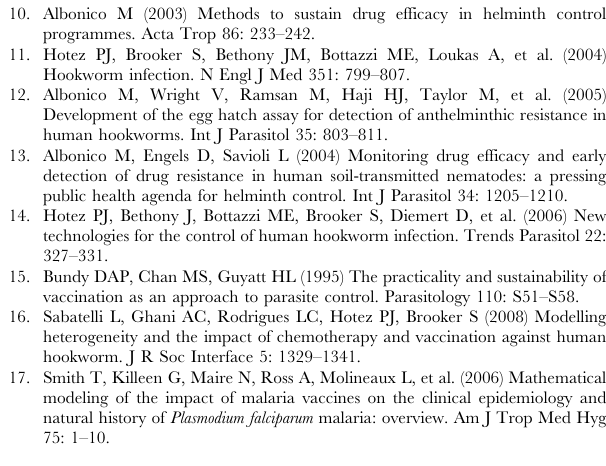
Figure S3 Results from a simple deterministic model. A) If the anthelmintic associated rate of death is higher than 0.35 the allele frequency follows two different time-dynamics depending on the degree of host-mixing r : i) it grows fast and then very slow ii) a slow initial growth is followed by an accelerated growth. B) Non- monotonic relation between the allele frequency after 20 annual chemotherapy rounds and r obtained for different values of d . The difference in allele frequency between the two dynamical regimes decreases as the selection-pressure-related parameter d increases. Baseline parameters are in Table 1 of the main paper. Figure S4 Effect of vaccination on the dynamics of drug resistance. In this example the vaccine reduces by a proportion VR the average reproductive rate of female parasites. A) Recessive case: the reduction in the spread of recessive resistant alleles primarily depends on the efficacy of the vaccine (in this example, the vaccine acts on female worm fecundity and r =85%). B) Dominant case: the reduction in the spread of dominant recessive alleles primarily depends on the reduction of the frequency of treatment (in this example, every 5 years instead of every year). Baseline parameters are in Table 1 of the main paper. Figure S5 Vaccine effectiveness (VE) when density dependence acts on the establishment of new worms. Vaccines can reduce the host susceptibility to infection (A–B), by a proportion VS, or the female parasite fecundity (C–D), by a proportion VR, or the parasite lifespan (E–F), or by a proportion VM. Vaccines reducing the parasite fecundity and vaccines reducing the parasite lifespan are more efficacious than vaccines reducing host susceptibility by the same proportion. Table S1 Univariate sensitivity analysis: Threshold for transition r from fast to slow dynamics of recessive alleles. The value of r , estimated at baseline, is 69%. Intervals refer to maximum and minimum r values. Impact of a vaccine reducing host suscepti- bility for VS =50% and r . Intervals of maximum and minimum percentage variation of vaccine impact VE, from baseline values VE = 18% (recessive) and VE= 17% (dominant) observed when parameter values vary within the given ranges. Baseline param- eters are in Table 1 of the main paper.